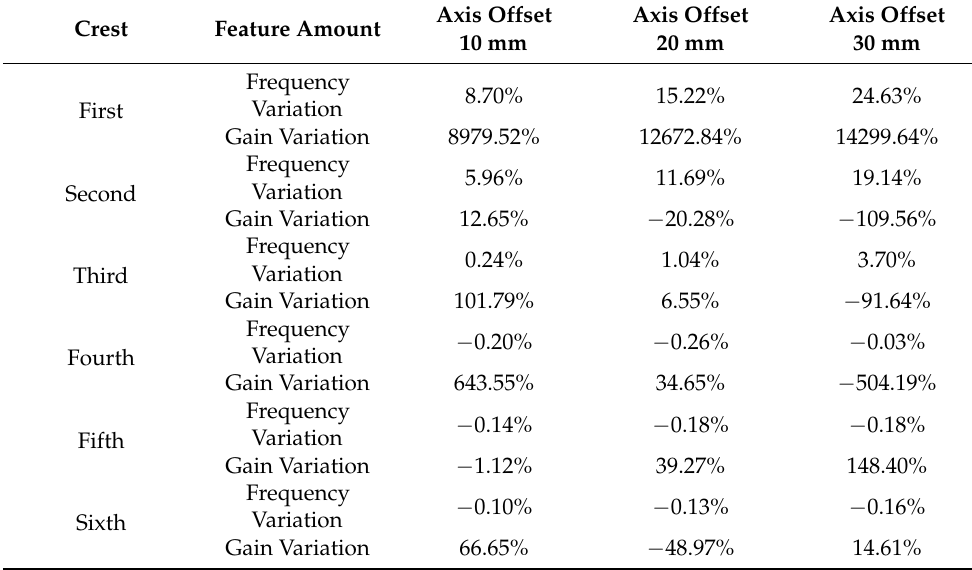
Table 15. Variation in peak frequency and amplitude